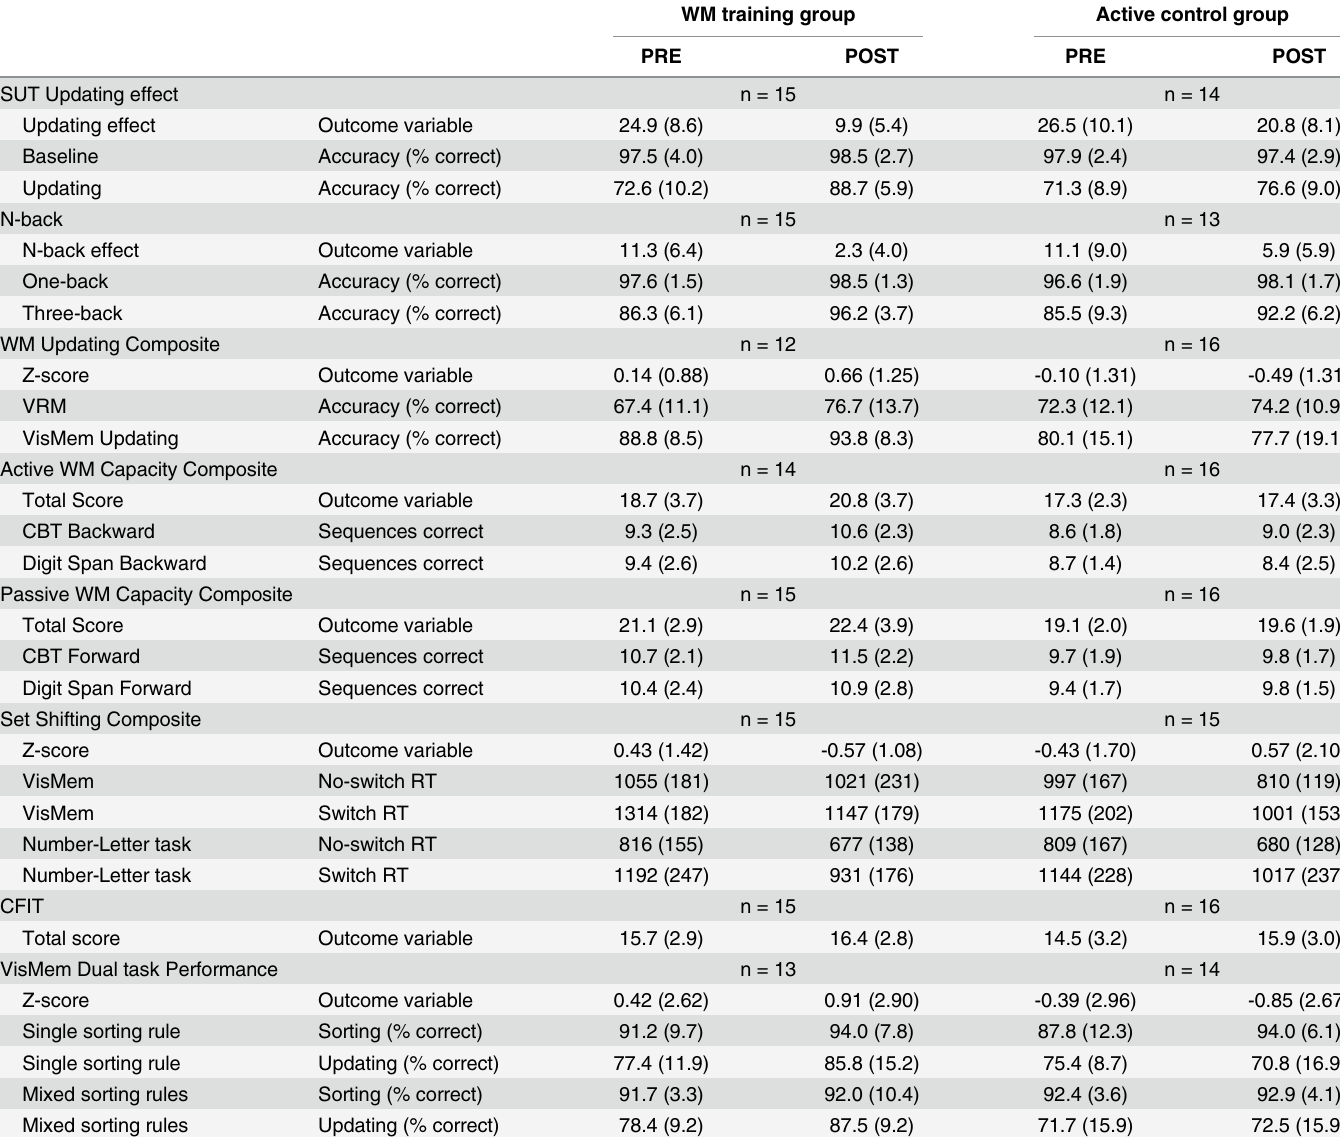
Table 2. Z-scores, accuracy rates, and RTs (in ms) for the outcome measures (means and